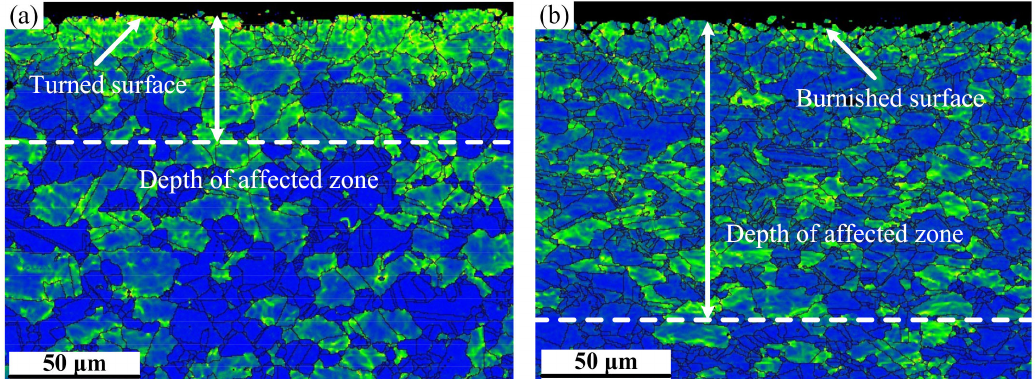
Figure 4. The evolution of the kernel average misorientation (KAM) map induced by ( a ) FT and ( b ) LPB